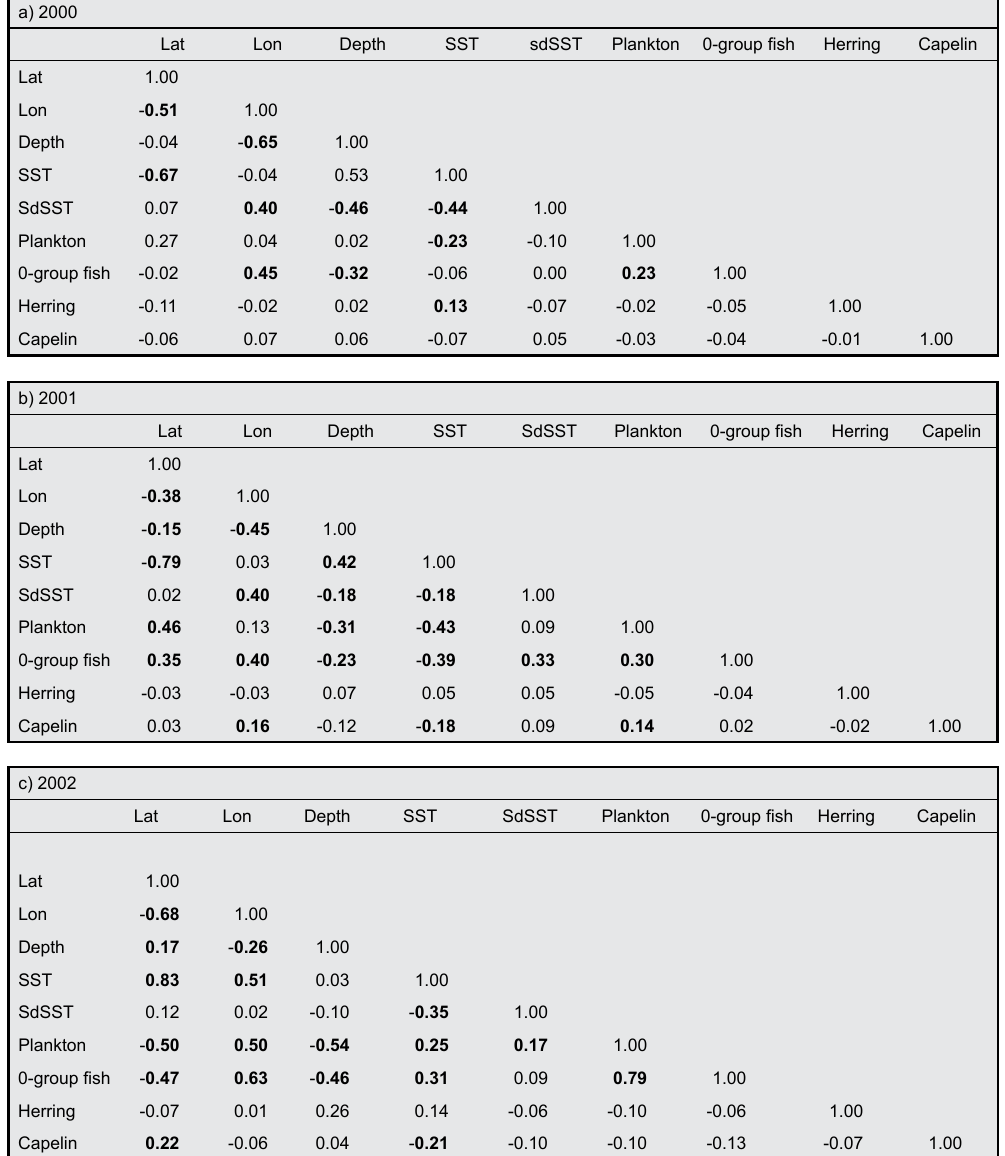
Table 3. Correlations between habitat and prey variables in 2000, 2001 and 2002. Significant correlations ( P ≤ 0.05) are in bold. a) 2000 Lat Lon Depth SST